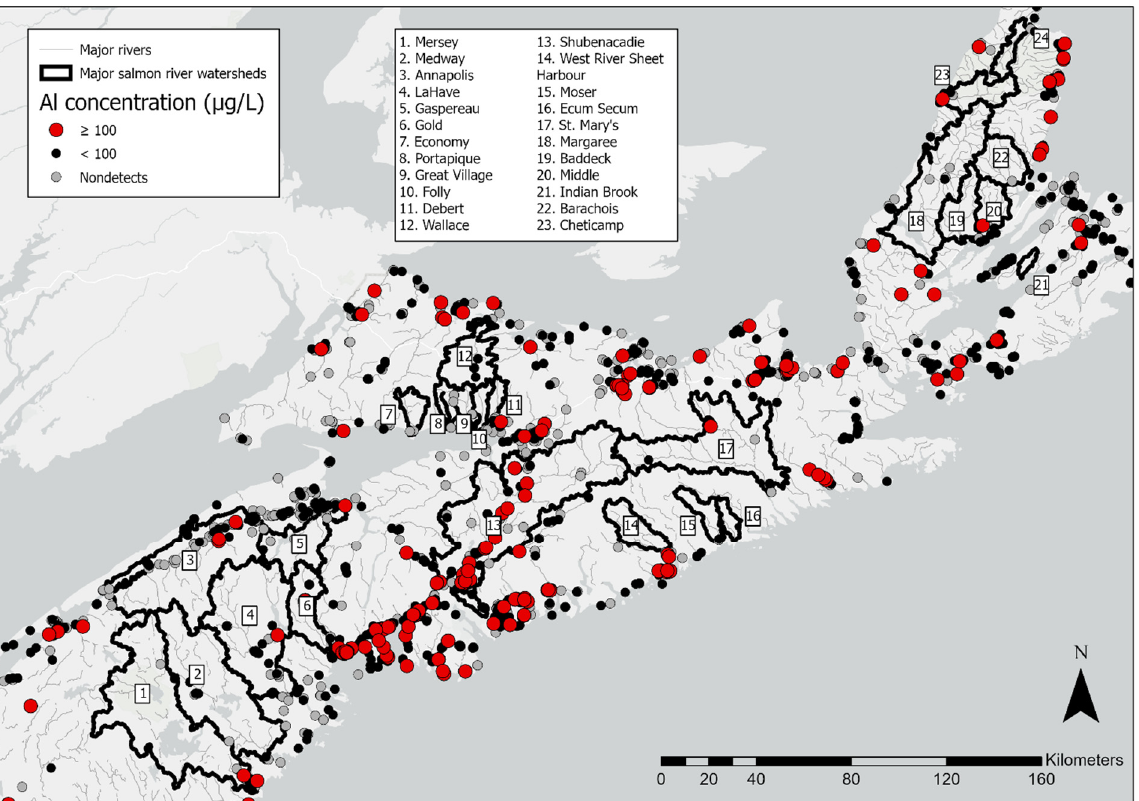
Figure 7. Aluminum concentrations in water wells compared to important salmon river watersheds.